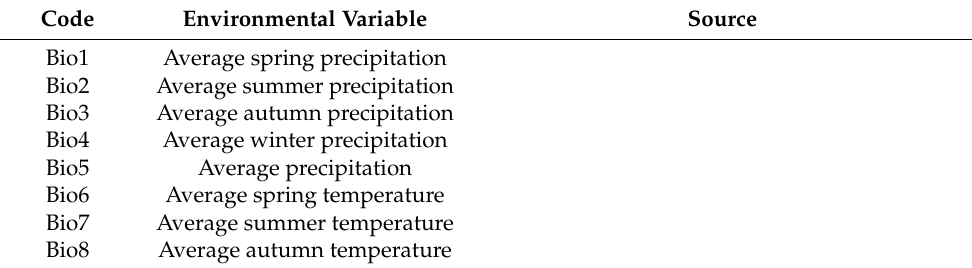
Table 1. Variables used for